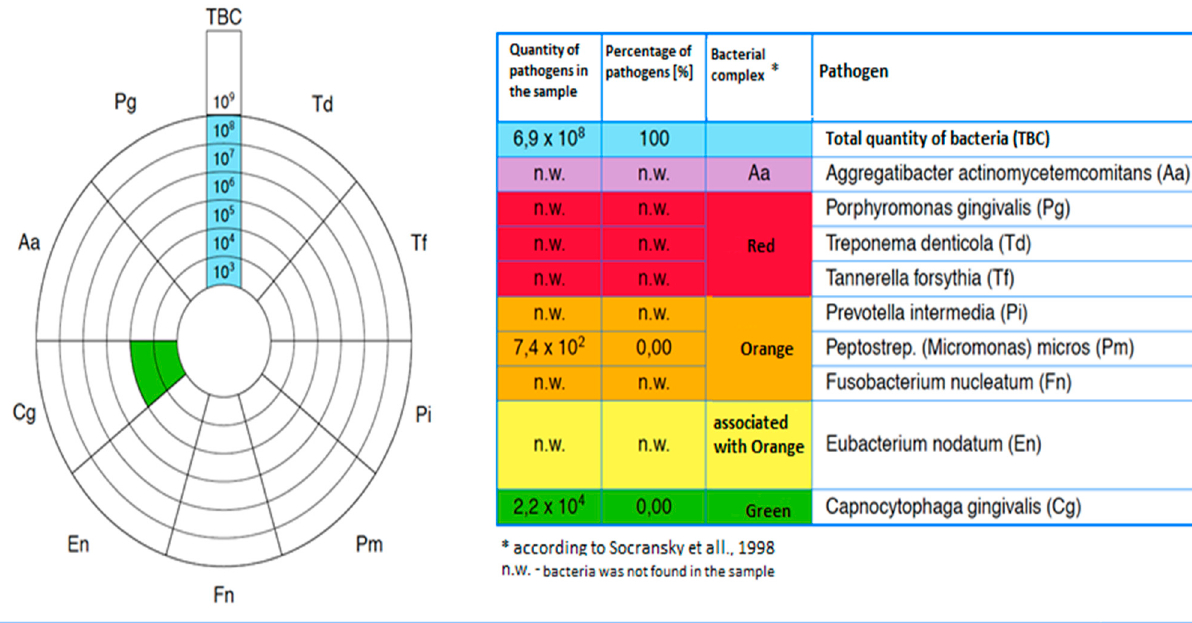
Figure 6. Bacterial profile of the biofilm present in the peri-implant pocket in th clinical case referred to in Figure 2, before ( A ) and after ( B ) treatment with a bioactive healing abutment (BHA) containing clindamycin. Real-time PCR